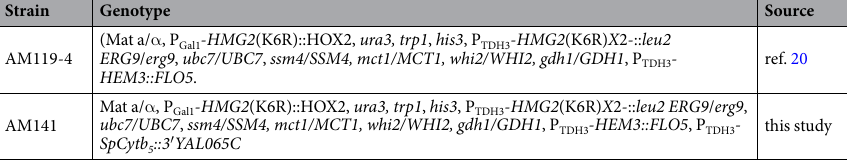
Table 1. List of S. cerevisiae strains used.